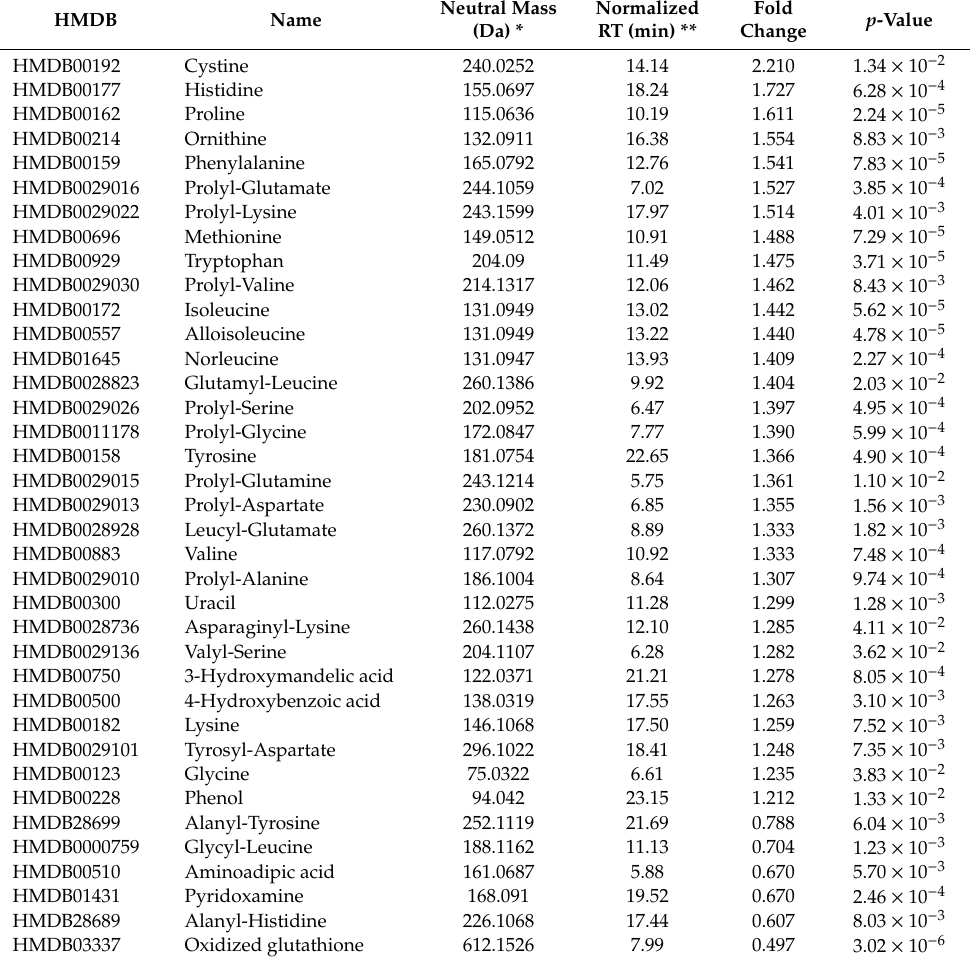
Table 2. Positively identified significantly di ff erentially expressed metabolites in the rat brain tissue after prolonged Dex treatment.